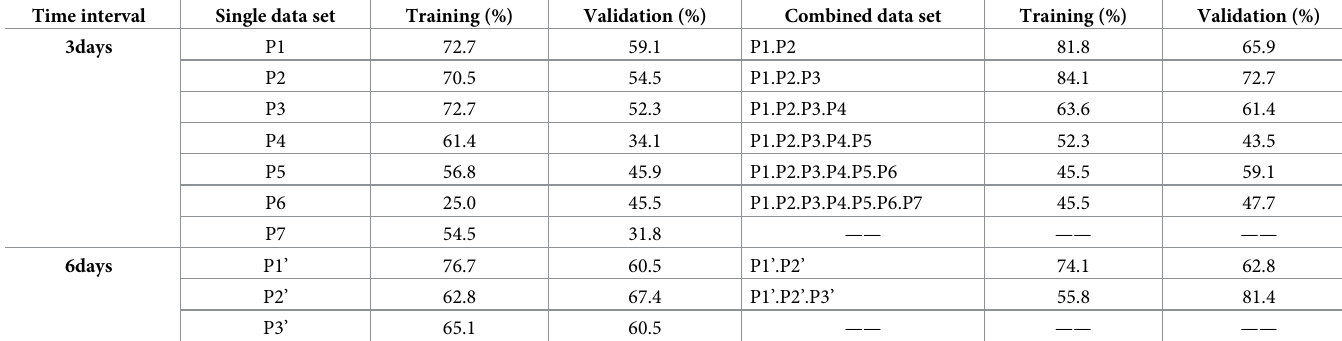
Table 6. Diagnostic accuracy of combining different leaf positions. Time interval Single data